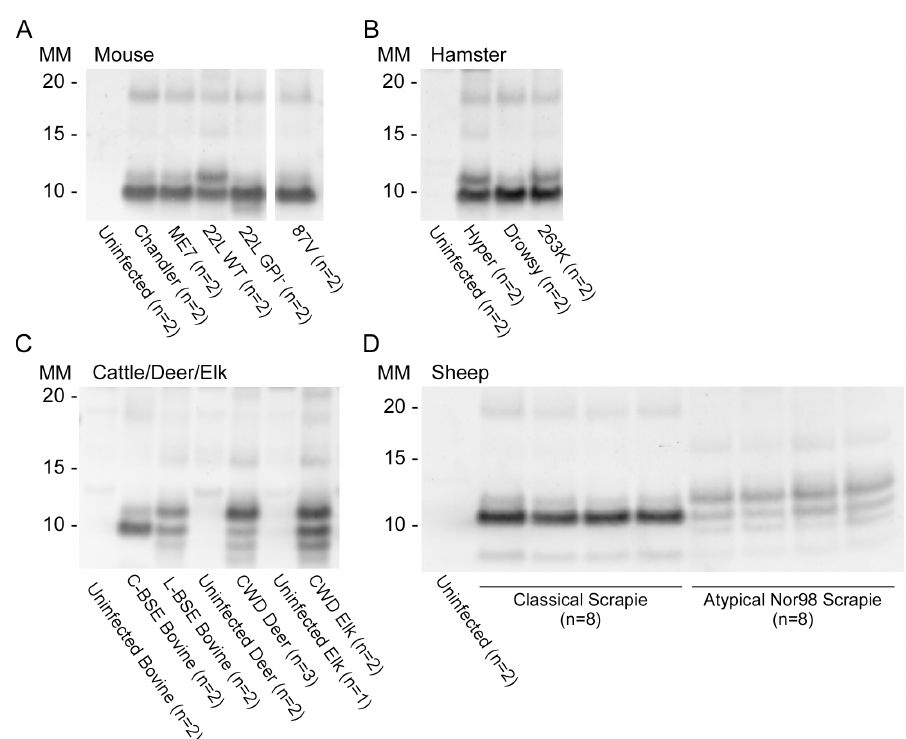
Fig 6. Western blot of BV rPrP Res from RT-QuIC reactions seeded with rodent, bovine, cervine and sheep prion types. PK-treated RT-QuIC products from mouse (A), hamster (B), cattle (C), deer (C), elk (C) and sheep (D) prion seeds were probed with R20 (hamster PrP epitope residues 218 – 231). In (D), the classical scrapie-seeded reactions include those seeded with samples from PRNP VRQ/VRQ and ARQ/ARQ sheep (not designated). The Nor98-seeded reactions were seeded with samples from ARR/ARR, ARQ/AHQ and ARQ/ARQ sheep. RT-QuIC reactions and immunoblotting analysis for each of these types of prions were performed at least twice with similar results. The banding profiles shown are representative of multiple (n) independently tested biological replicates.